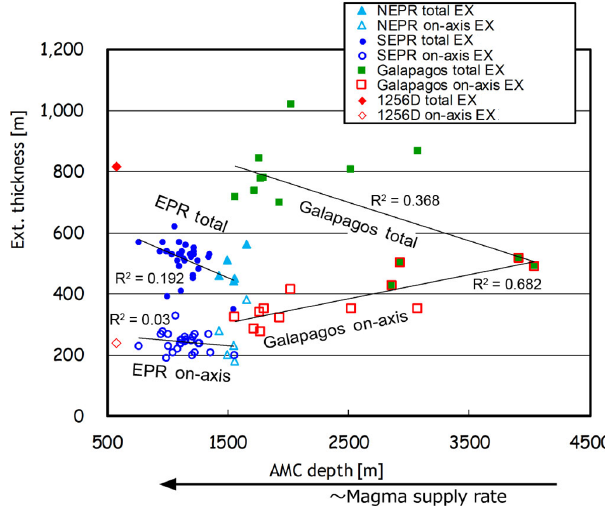
Figure 7. Extrusive thickness plotted against the AMC depth for the present Galapagos Spreading Center and the East Pacific Rise (EPR) segments and the 15Ma 1256D crust. Solid and open sym- bols are data based on total and on-axis extrusive thicknesses. Data sources are Hooft et al. (1997; SEPR, NEPR), Blacic et al. (2004; GSC), Tominaga et al. (2009; Hole 1256D), and Tominaga and Umino (2010; Hole